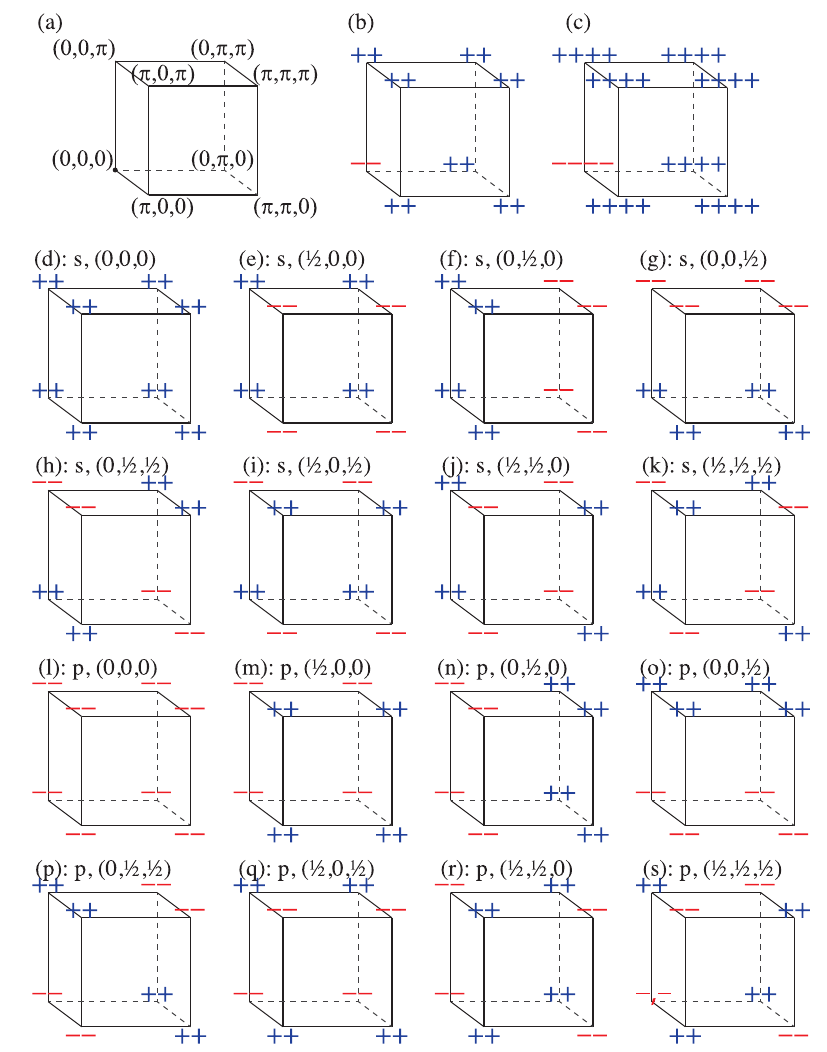
FIG. 1. The parity eigenvalues at high-symmetry momenta. (a) The common choice of coordinates in panels (b) – (s). (b,c) An example of the parity eigenvalues for a strong topological insulator ( κ 1 ¼ 3 , ν 0 ¼ 1 , and ν 0 ), respectively. Diagram (c) can be realized by stacking two copies of diagram (b). (d) – (k) The parity eigenvalues of the and ν 0 ¼ ν i ¼ atomic insulators constructed by placing an s orbital at the position specified in each panel in every unit cell. (l) – (s) The same for (d) – (k) but with a p orbital used instead of an s orbital. All atomic insulators have κ 1 ¼ ν 0 ¼ ν ν ν 0 , and diagram (l), κ − 4 , ν ν 0 0 ¼ 1 ¼ 0 ¼ i ¼ i ¼